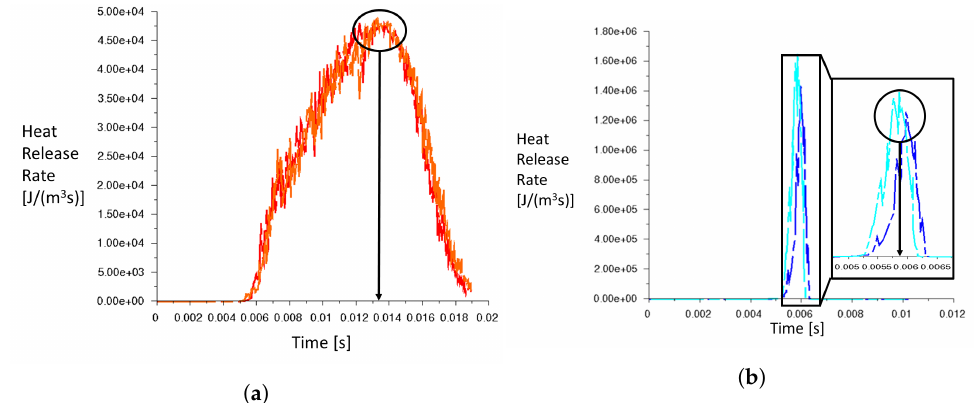
Figure 20. Heat release rate trends against time: ( a ) CH 4 –air mixture, ( b ) H 2 –air mixture.